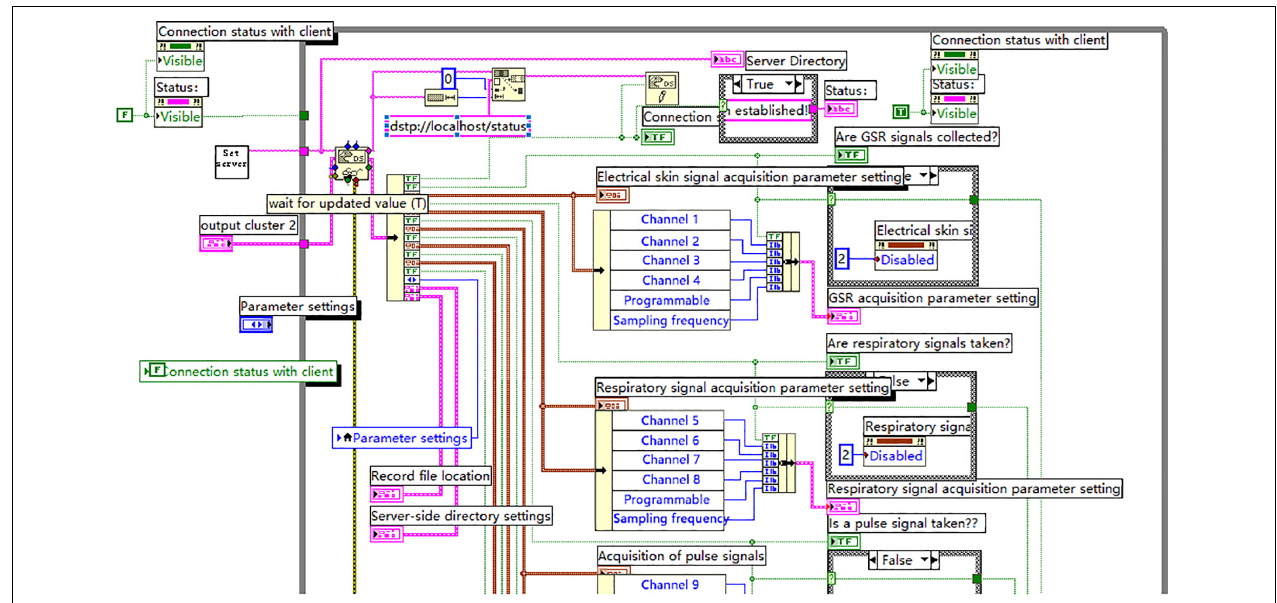
FIGURE 6 | The chart program to real-time collect, display and store physiological signals at the server end